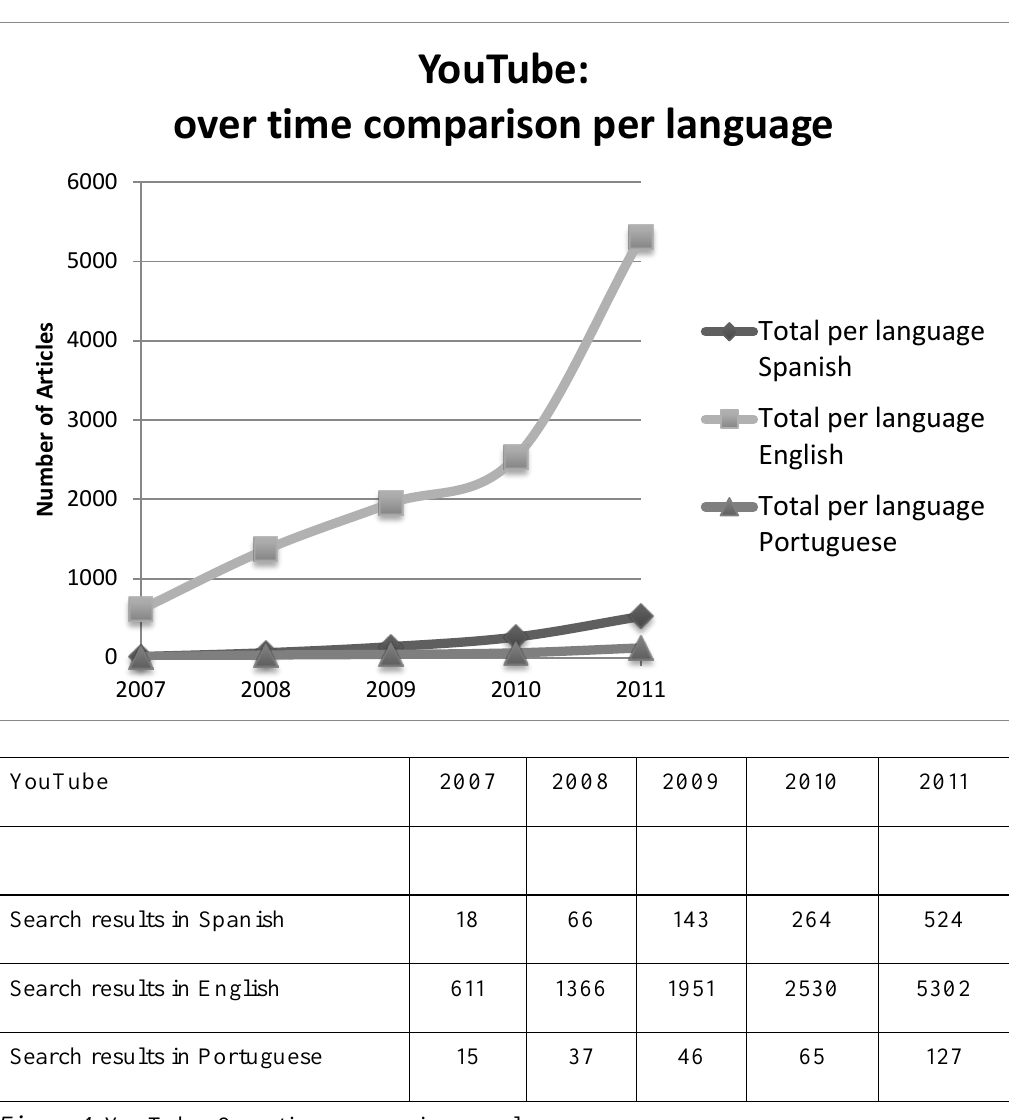
The data gathered from non-academic platforms (Scribd and YouTube) indicates that search results in English were continuously growing during the period